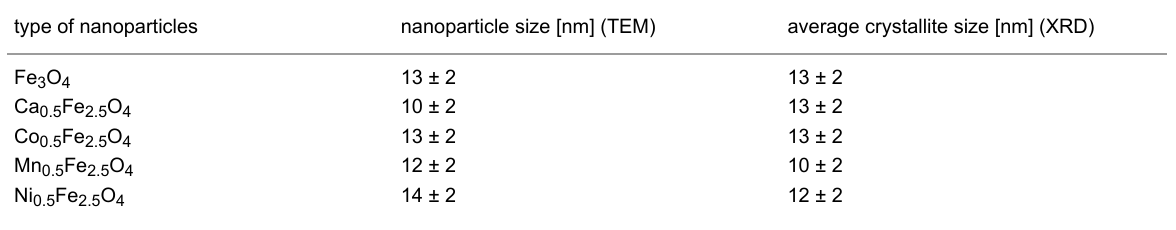
Table 1: Table with average crystallite sizes of ferrite nanoparticles estimated from TEM images sizes and calculated from the XRD